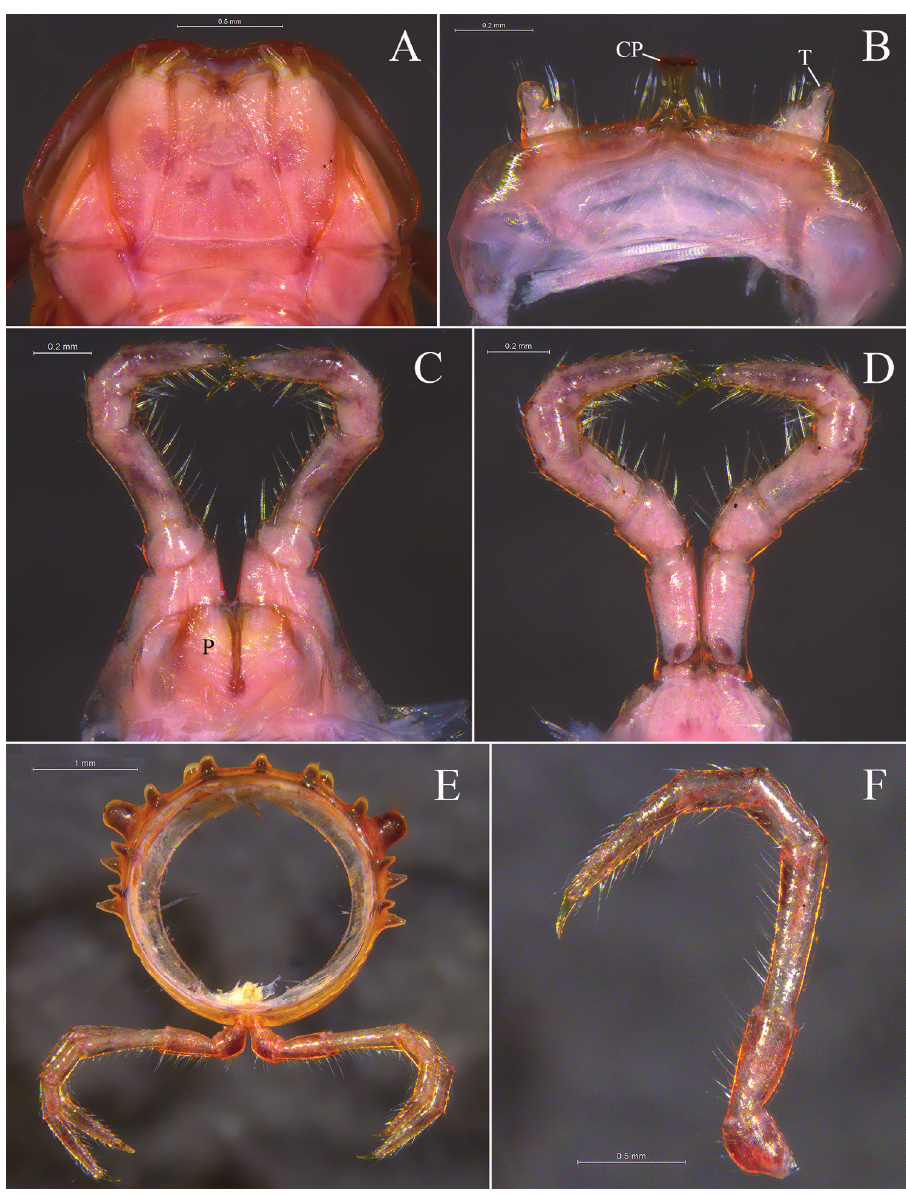
Figure 18. Glyphiulus impletus sp. n., holotype. A gnathochilarium, ventral view B legs I, anterior view C legs II, caudal view D legs III, caudal view E cross-section of a midbody segment, caudal view F midbody leg, anterior view. Abbreviations: CP = coxal process; P = penes; T = telopodite. Jan. 2017, H.M. Chen & C. Chen leg. (IBGAS); 17 males, 24 females and 24